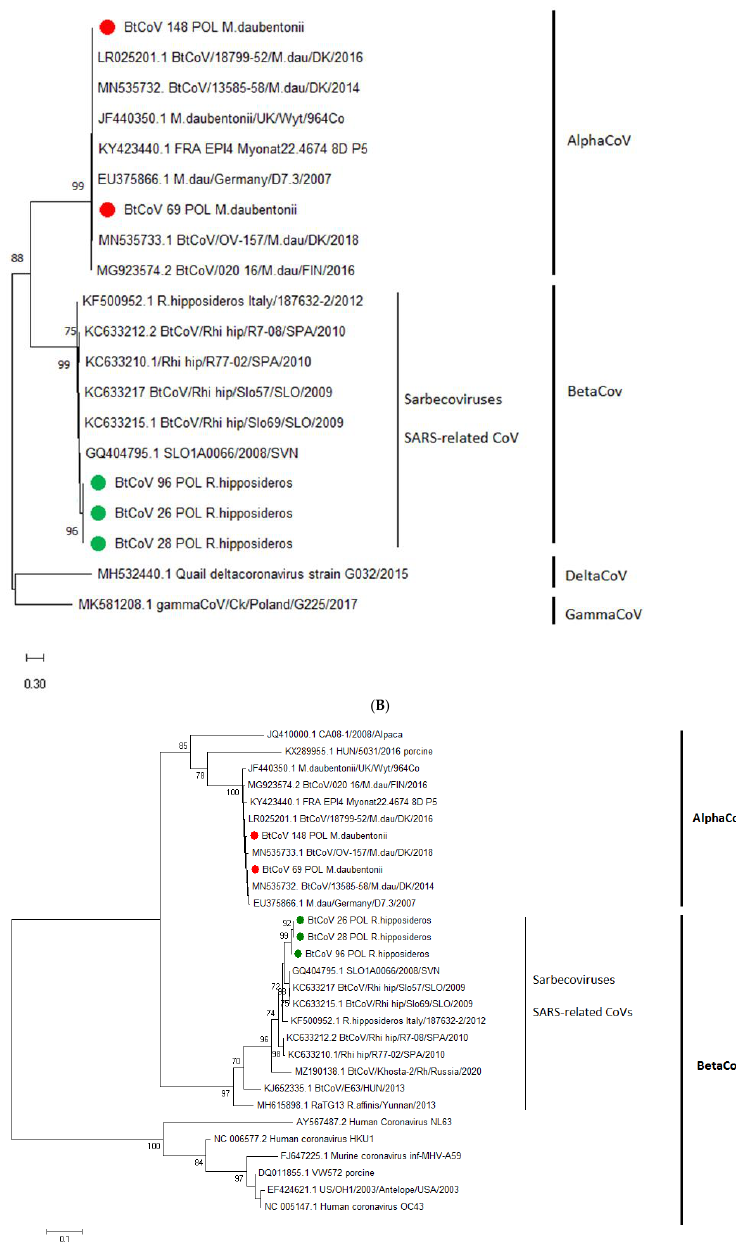
Figure 2. Phylogenetic tree based on the 379 bp-long nucleotide fragment of the RNA-dependent RNA polymerase gene of BtCoVs selected as the most homologous ( A ) and BtCoVs detected in Po- land and the other distinct CoVs ( B ), generated using the neighbor-joining method with the Ki- mura2-parameter model and MEGA 5 software. Green circles indicate SARS-related CoVs detected in horseshoe bats in Poland, whereas red circles refer to alphacoronaviruses detected in Myotis bats in Poland. Bootstrap values (1000 replicates) over 70% indicating significant support for the tree topology are shown next to the branches. Sequences of delta- and gamma CoVs isolated from poul- try in Poland were used as the outgroup in Figure 2A. 4. Discussion Numerous human and animal disease outbreaks in recent decades have identified bats as the source of various pathogens that pose a threat to both animal and public health on an ongoing basis. For the first two relevant epidemics of the 21st century, SARS in Asia and MERS in the Middle East, bat-borne transmission of coronaviruses was confirmed. The etiological agent of the current COVID-19 pandemic, SARS-CoV-2, likely originated from horseshoe bats, based on the over 96% identity to a SARS-related coronavirus iso- lated in a rhinolophid bat in 2013 in Yunnan province, China. Since the SARS epidemic in 2003 and the beginning of the intensive search for novel CoVs in various mammals, over 500 new CoVs have been identified in bats [35]. Some of the SARS-related CoVs identified in horseshoe bats in China easily replicated in human cells because they use angiotensin- converting enzyme 2 (ACE2) as their main cellular receptor which is present in both hu- mans and bats [36]. Five of the seven human CoVs detected so far, i.e., the HCoVs-229E and HCoVs-NL63 alphacoronaviruses and SARS-CoV, MERS-CoV, and SARS-CoV-2, are